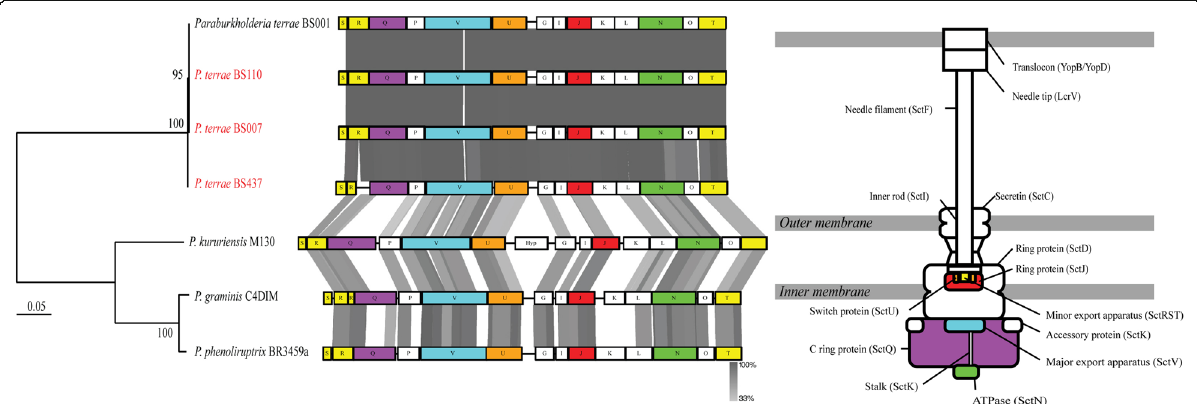
Fig. 6 Synteny comparison of Hpr-2 type-3 secretion systems (T3SS) used in the phylogenetic tree. Evolutionary distance was computed with MEGA7 using a maximum-likelihood method. The bootstrap values above 50% (from 1000 replicates) are indicated at the nodes. The tree was generated based on alignment of eight conserved genes of the T3SS ( SctS, SctR, SctQ, SctV, SctU, SctJ, SctN, and SctT ) indicated by the colored boxes. The letter in the boxes indicates the last letter of the Sct gene. Comparison percentage was generated using BLAST+ 2.4.0 (tBLASTx with cutoff value 10 − 3 ) and map comparison figures were created with the Easyfig program [33]